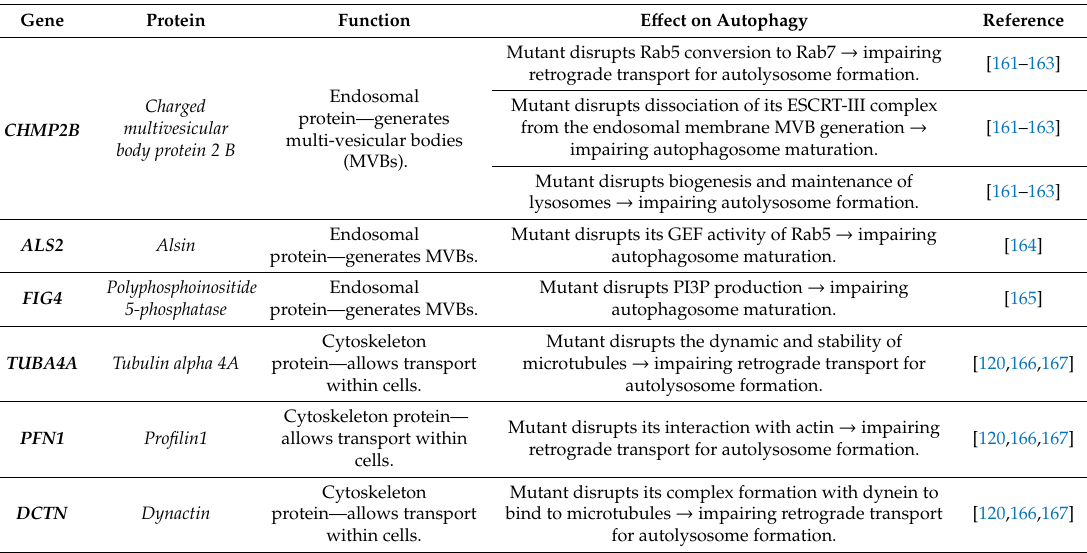
Endosomal protein—generates